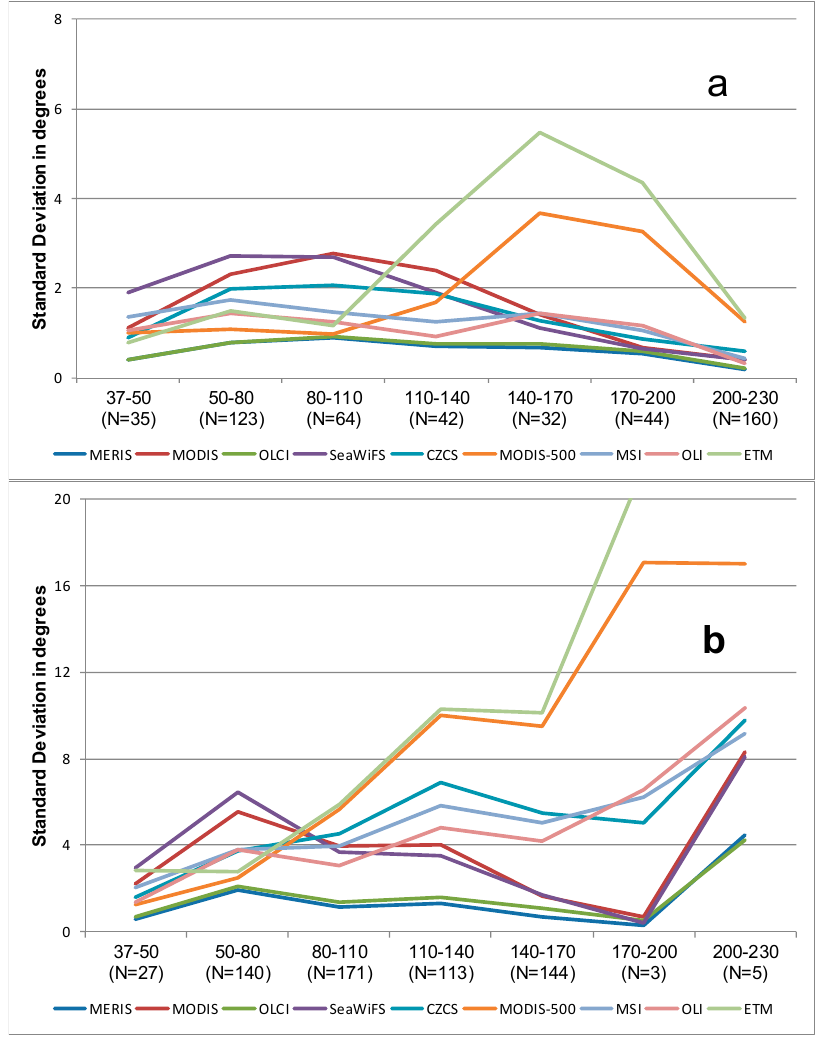
Figure 6. Plot of the standard deviation in the parameter ( α -sensor minus α -hyperspectral) for nine sensors. On the horizontal axis, the hyperspectral hue interval is given in degrees, together with the number of spectra (N) that were used to calculate the standard deviation. The upper panel ( a ) is based on the International Ocean Colour Coordinating Group (IOCCG) data, and the lower panel ( b ) is based on the field data.